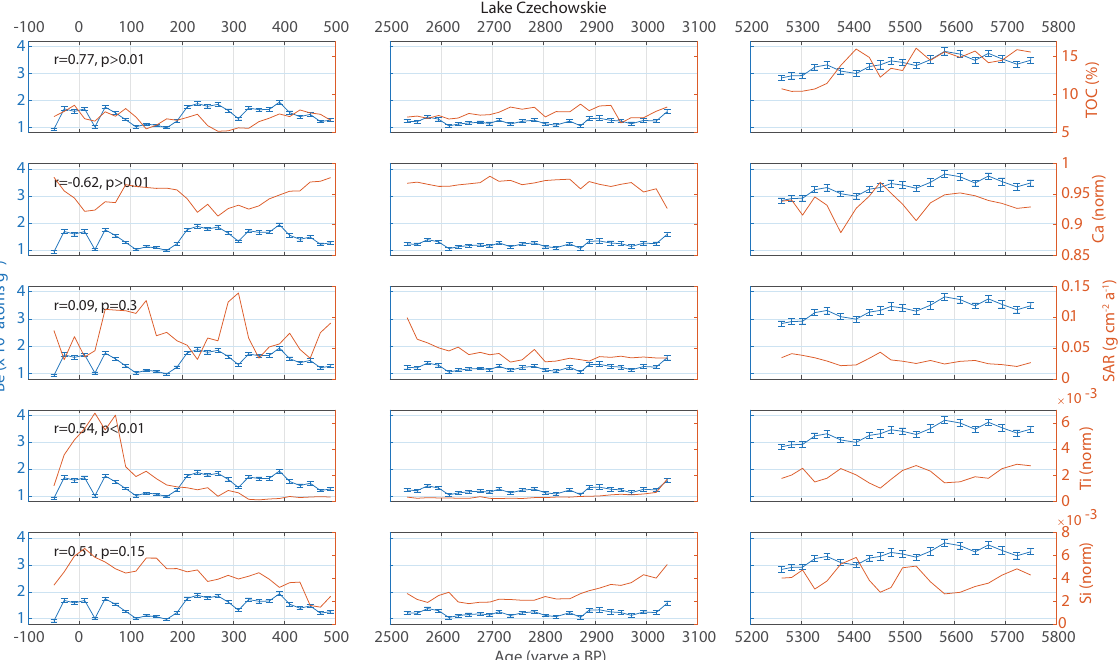
Figure 3. 10 Be concentrations ( 10 Be con ) in Lake Czechowskie (JC) sediments around the Maunder, Homeric and 5500aBP grand solar minima and corresponding proxy time series from the same archive. 10 Be con compared with sediment accumulation rates (SARs), total organic carbon (TOC), Ti, Ca and Si. Correlation coefficients were calculated for the complete time series covering all three grand solar minima. Significance levels of correlations were calculated using 10000 iterations of a nonparametric random phase test taking into account trend and autocorrelation present in the time series (Ebisuzaki, 1997). Error bars indicate AMS measurement